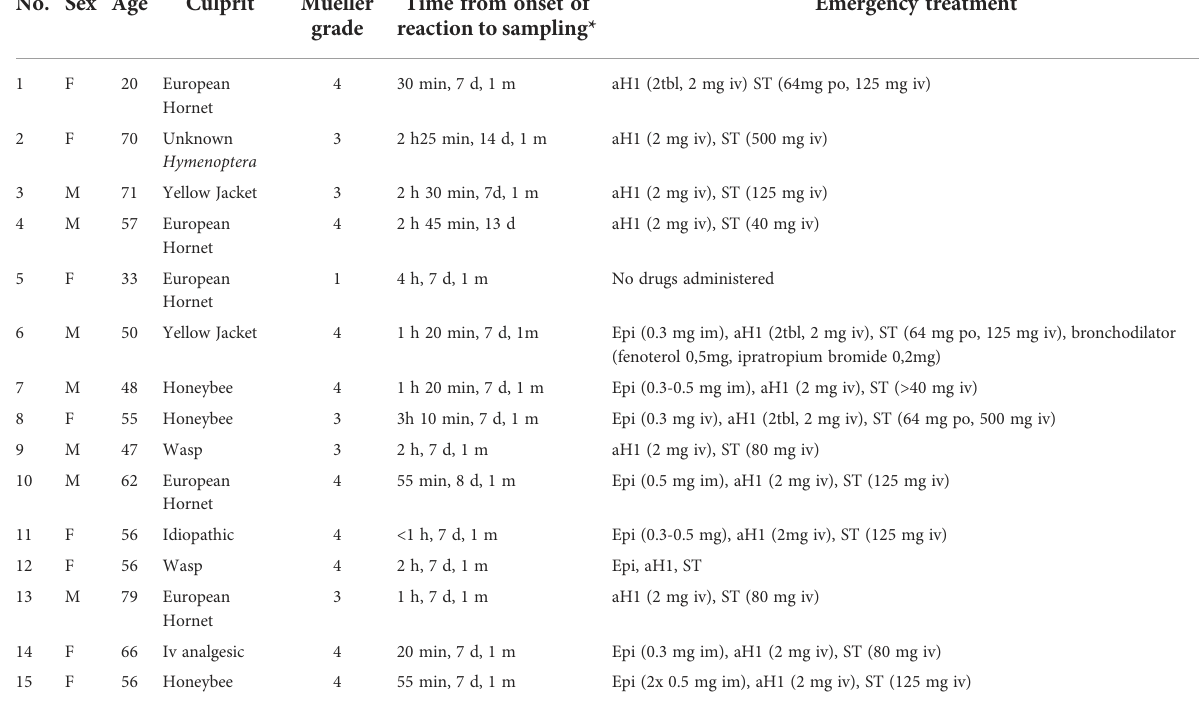
TABLE 1 Patients with acute anaphylactic reactions recruited from the hospital emergency department. No. Sex Age Culprit Mueller Time from onset of grade reaction to